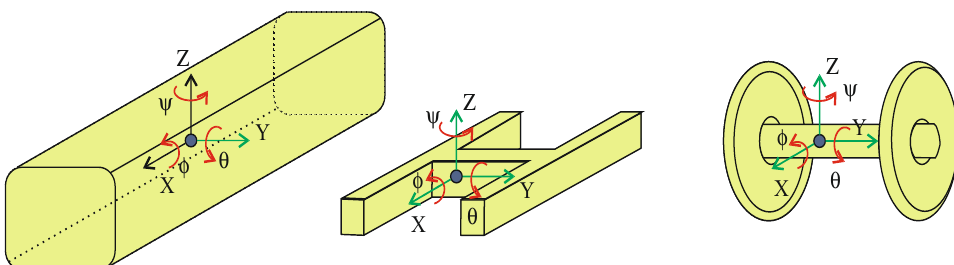
Figure 3 . Coordinate systems in rigid bodies of a rail vehicle .